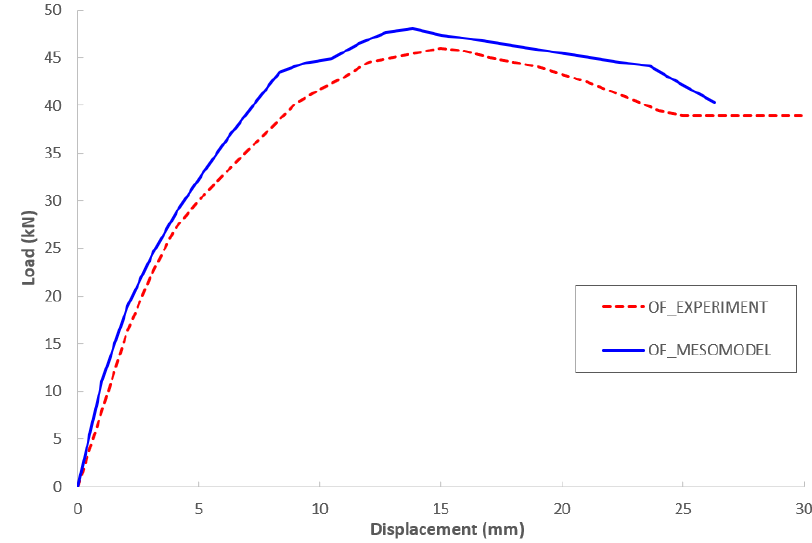
Figure 5. Capacity curve between open frame testing and meso modeling. Table 6. Validation results for open frame meso model vs. experiment.